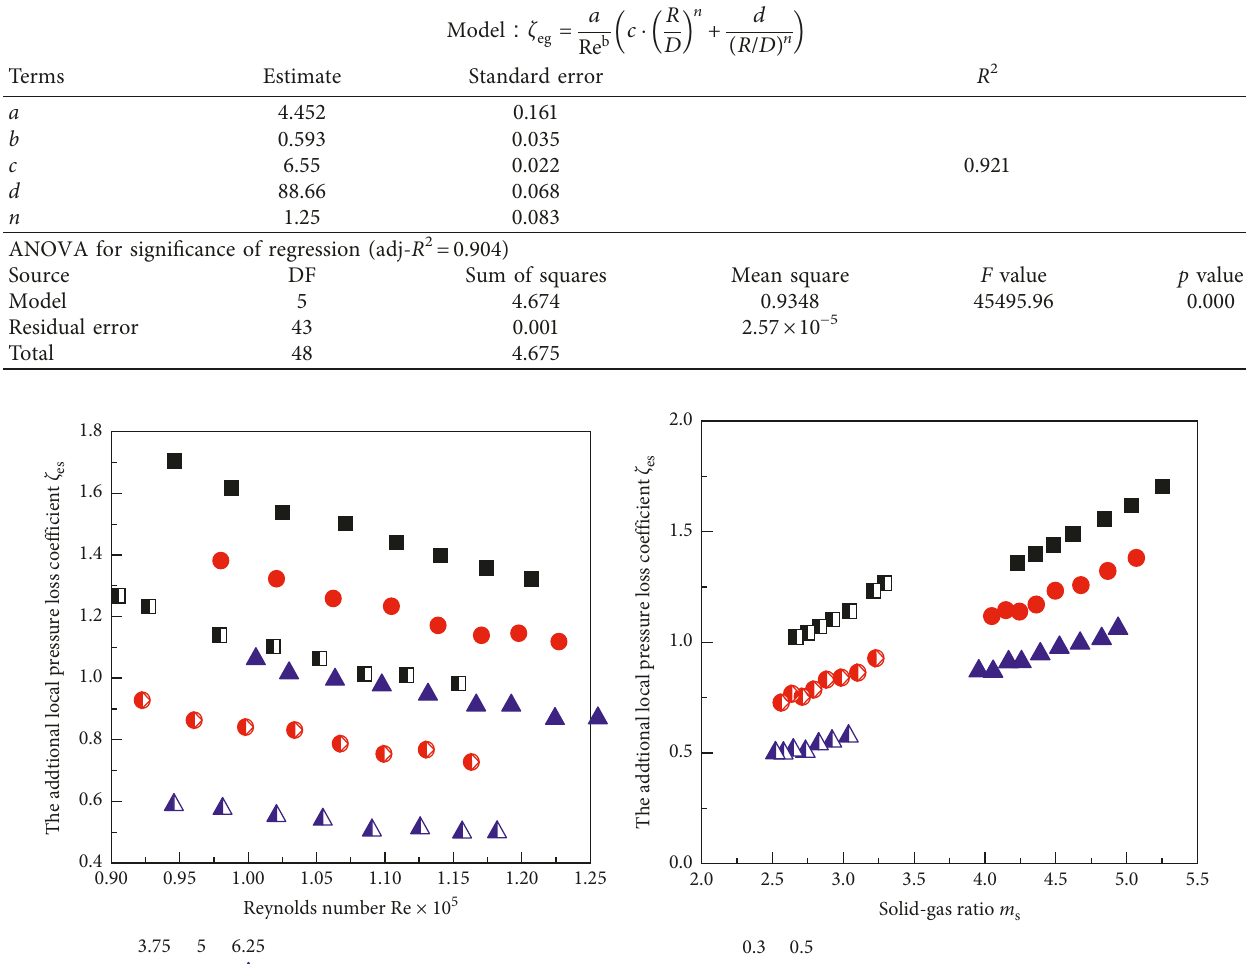
Table 1: Analysis of nonlinear regression.